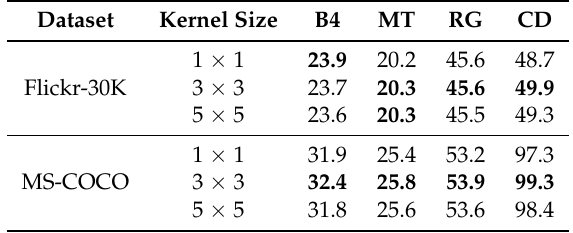
Table 3. The result of spatial structure effective in spatial